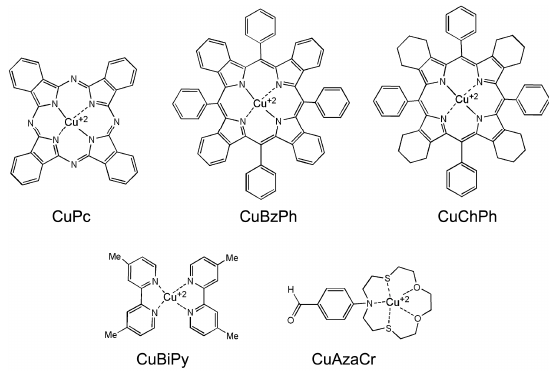
Figure 1. Structures of the metalorganic compounds used for SnO 2 modification.